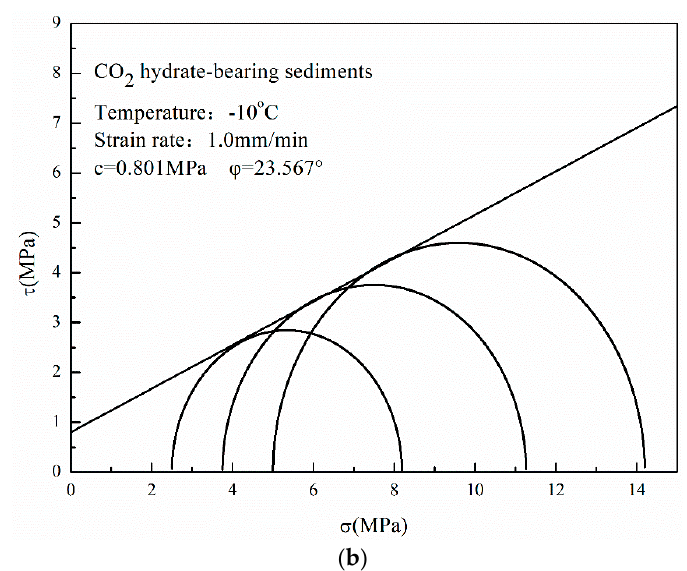
Figure 14. Mohr’s stress circles and the envelopes of CH 4 and CO 2 hydrate-bearing sediments under confining pressures of 2.5, 3.75, and 5 MPa. ( a ) CH 4 hydrate-bearing sediments; ( b ) CO 2 hydrate-bearing sediments.